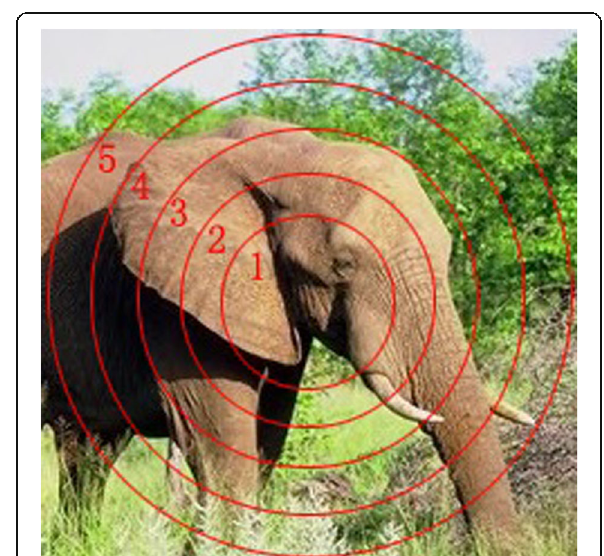
Fig. 1 Annular geometric segmentation